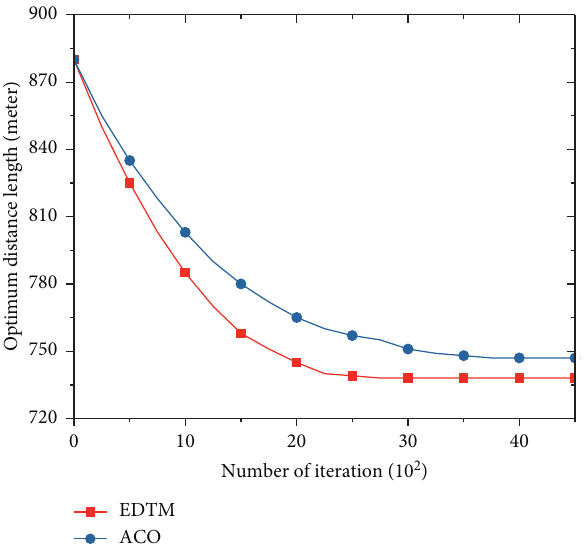
Figure 13: The comparison of total migration cost between the proposed EDTM algorithm and the algorithm MDP-SD algorithm.